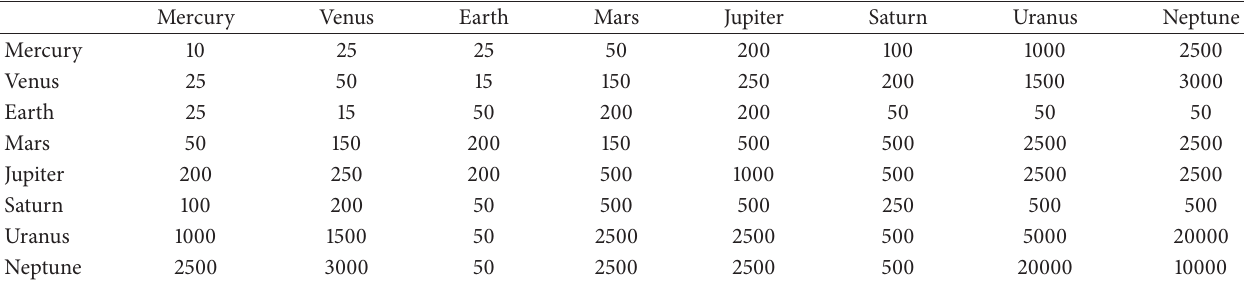
Table 15: The minimum transfer duration between random two planets.